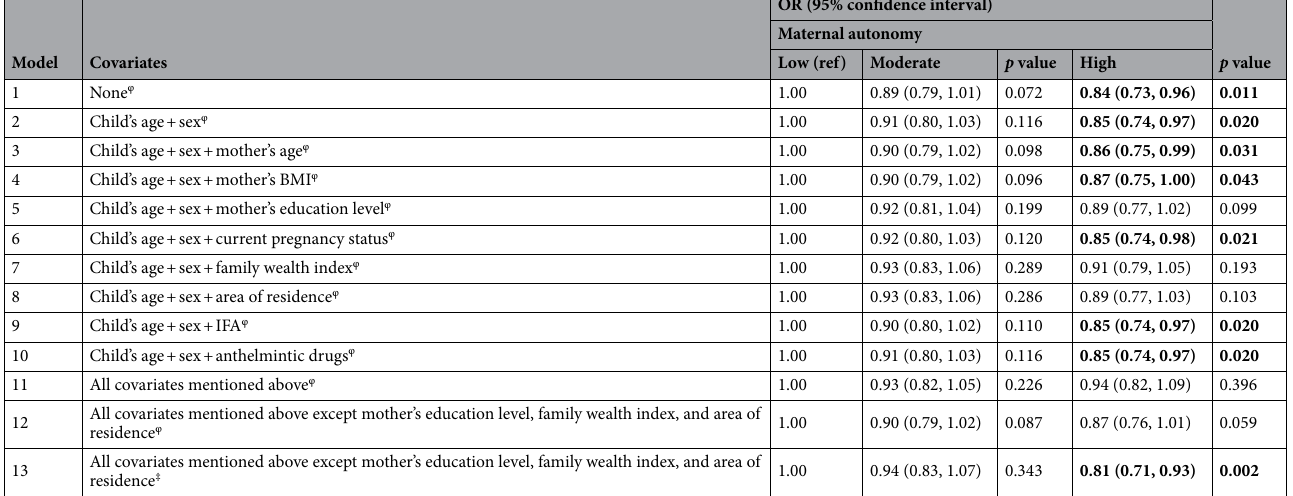
Table 3. Sociodemographic factors mediating the effect of maternal autonomy on child stunting. φ Adjusted for multilevel clustering using the standard enumeration area (SEA) and survey year (MDHS 2010–2015/16) variables. ‡ Adjusted for clustering using the SEA variable only. OR, odds ratio; BMI, body mass index; IFA, iron and folic acid supplementation; MDHS, Malawi Demographic and Health Survey; ref, reference category. Statistical significance was set at p < 0.05. Significant p values are in